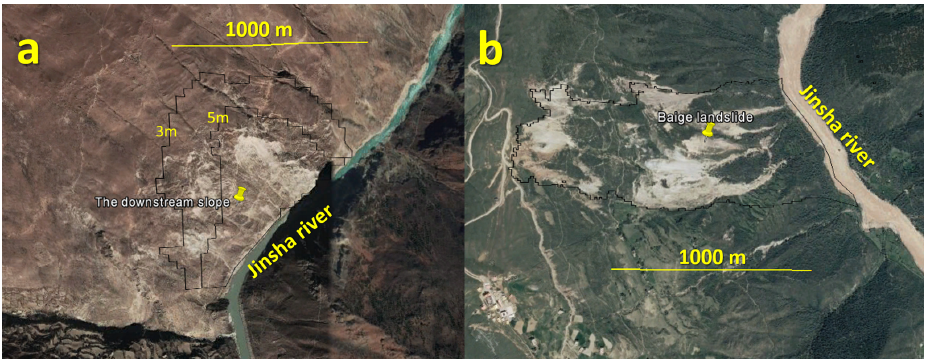
Figure 7. High-spatial-resolution images from © Google Earth. The image to the left was acquired on 30 March 2015 for the Mindu slope (a) , and the right image was acquired on 18 July 2017 for the Baige slope (b)